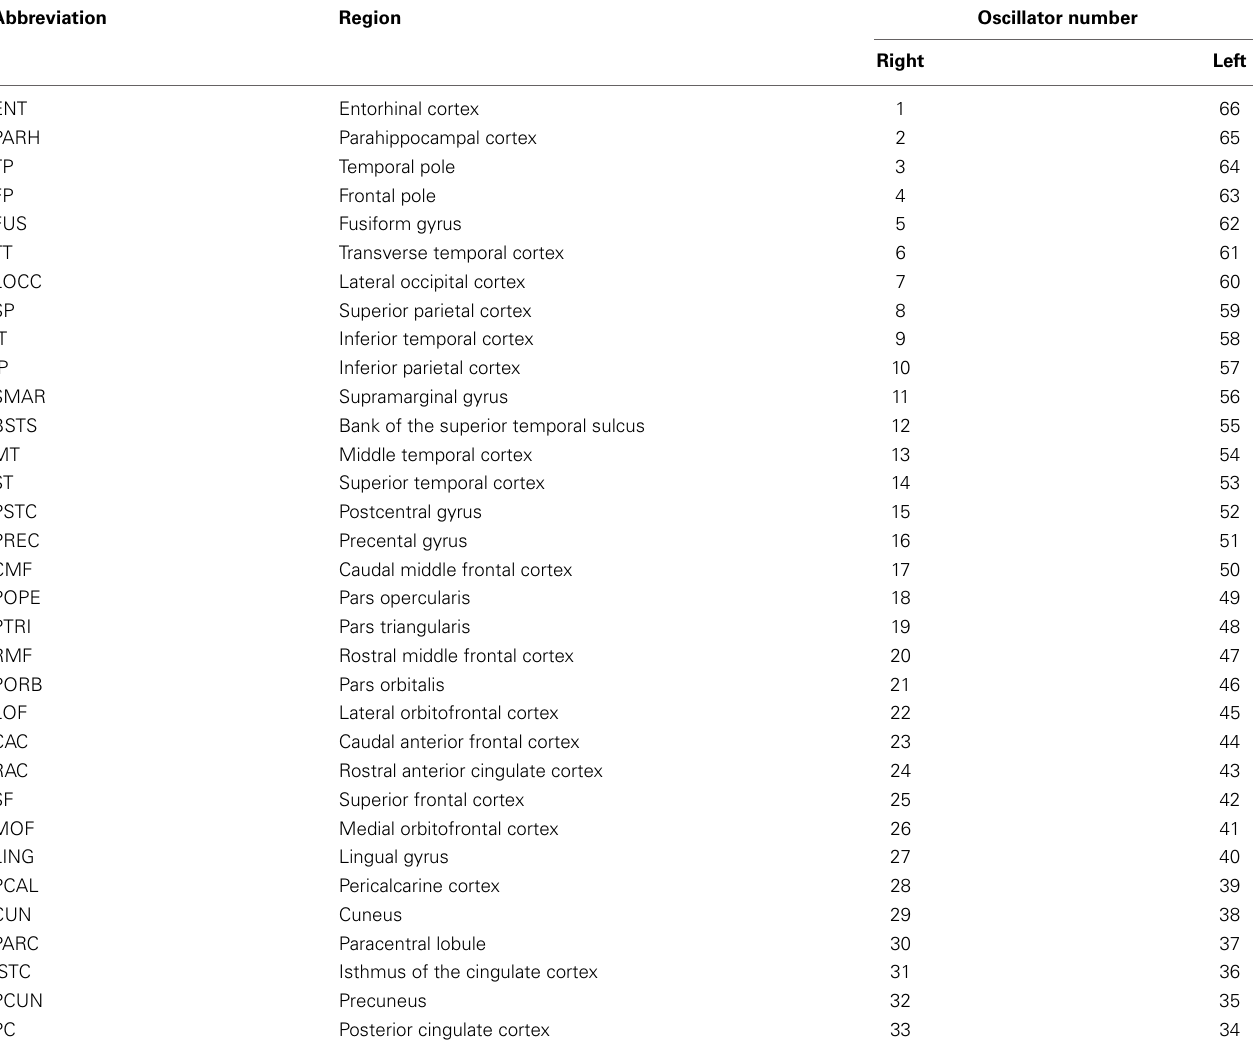
The abbreviations, full names, and oscillator numbers corresponding to the left and the right hemispheres are given for each brain region. The labels, brain regions, and oscillator numbers used in the Cabral